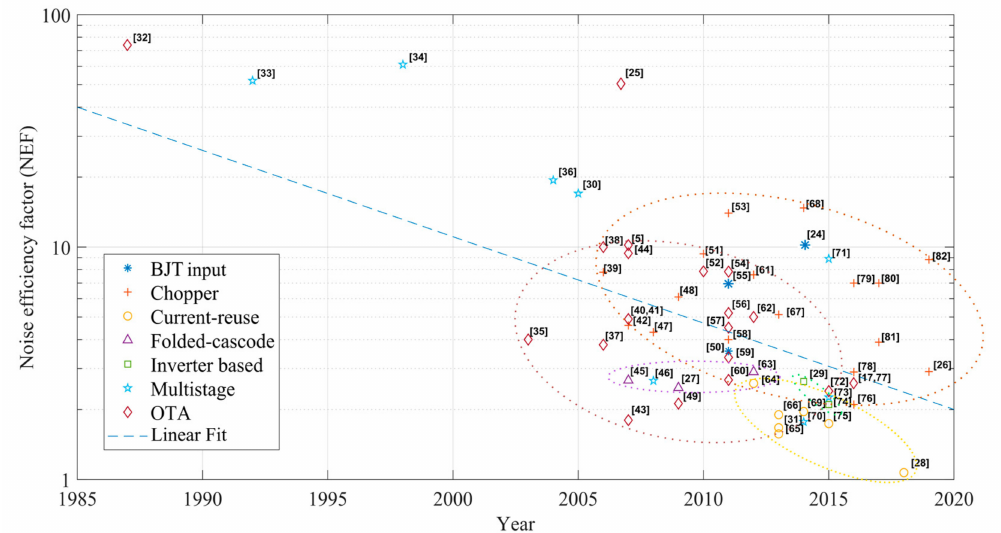
Figure 2. Noise efficiency of different CMOS-based amplifiers for biomedical applications, divided into seven categories. Each marker represents the calculated NEF of the noted reference [32–82] based on measured data ([17,77] are simulated noise data). Groups of data points of the same category are indicated by circles. The dashed line shows the best linear fit through all data points on the logarithmic scale. Designs marked as BJT input are realized with lateral BJT in CMOS